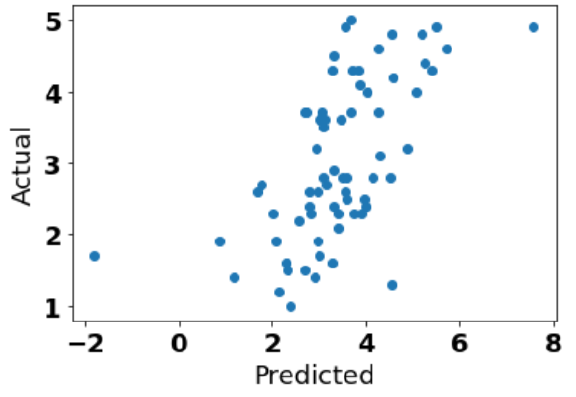
Figure 6. Scatterplot of Rate My Professor ratings: actual mean rating vs. predicted mean